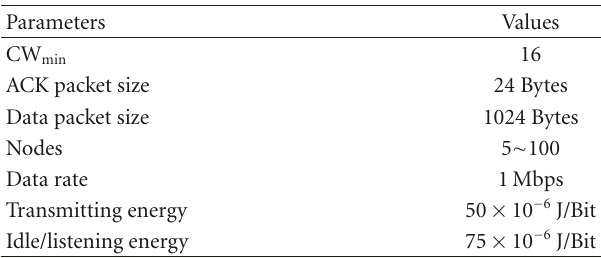
Table 4: Simulation